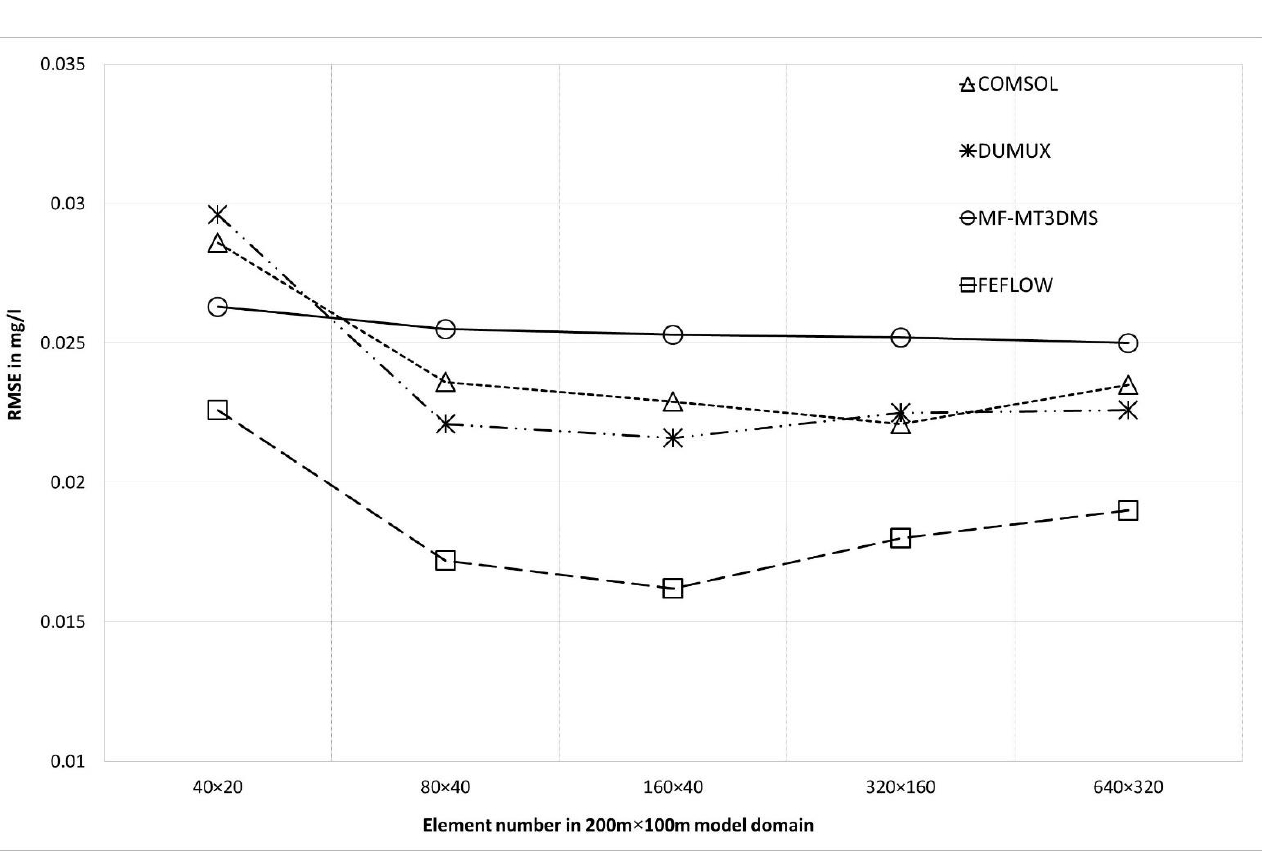
Figure 8. Spatial discretisation sensitivity on the solution accuracy convergence in different simulators for a standard dispersivity of 5 m.